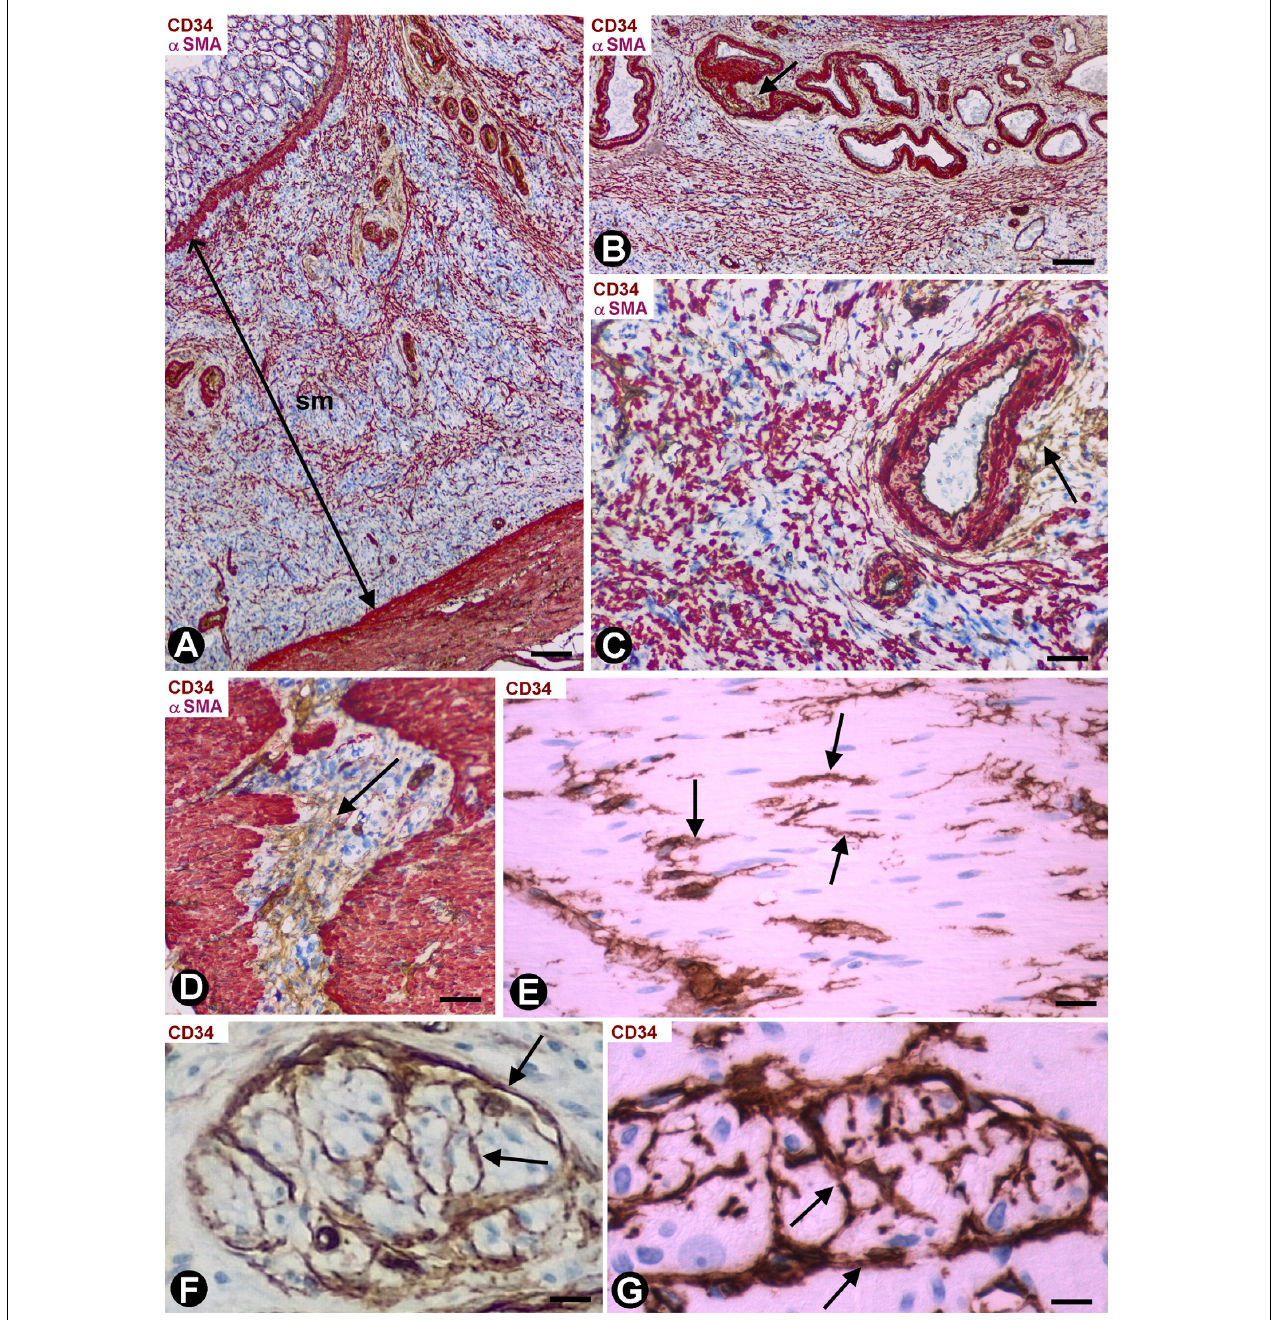
FIGURE 5 | Stromal cells in segments of colon following resection of malignant polyps, tattooed with India ink, and with an intense infiltrate of macrophages. (A) Activated stromal cells are present in the submucosa and absent in the mucosa. Note that the activated stromal cells in the submucosa (sm) are α SMA+ (red). Infiltrates of macrophages are also observed in the mucosa and submucosa. (B,C) Absence of stromal cell reaction in the adventitia of large submucosal vessels, in which the CD34+SCs/TCs (brown, arrows) are conserved. (D,E) Activated CD34+SCs/TCs (brown) in the connective tissue between ( D , arrow) and within ( E , arrows) muscle fascicles. (F,G) Presence of CD34+SCs/TCs (brown) in a nerve ( F , arrows) and in a myenteric ganglion ( G , arrows). (A–D) Double staining with anti-CD34 (brown) and anti-SMA (red). (E–G) Sections stained with anti-CD34. Bar: (A) 60 µ m; (B) 40 µ m; (C–F) 20 µ m; (G) 15 µ m.